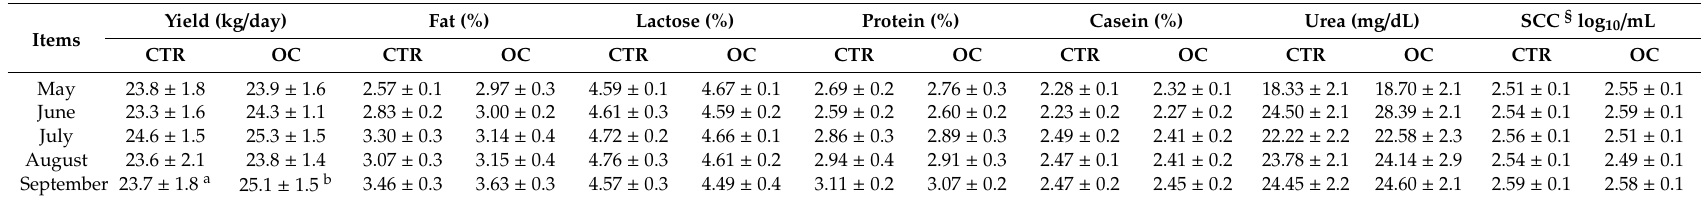
Table 5. E ff ect of olive cake supplement on milk yield and composition (mean values ±